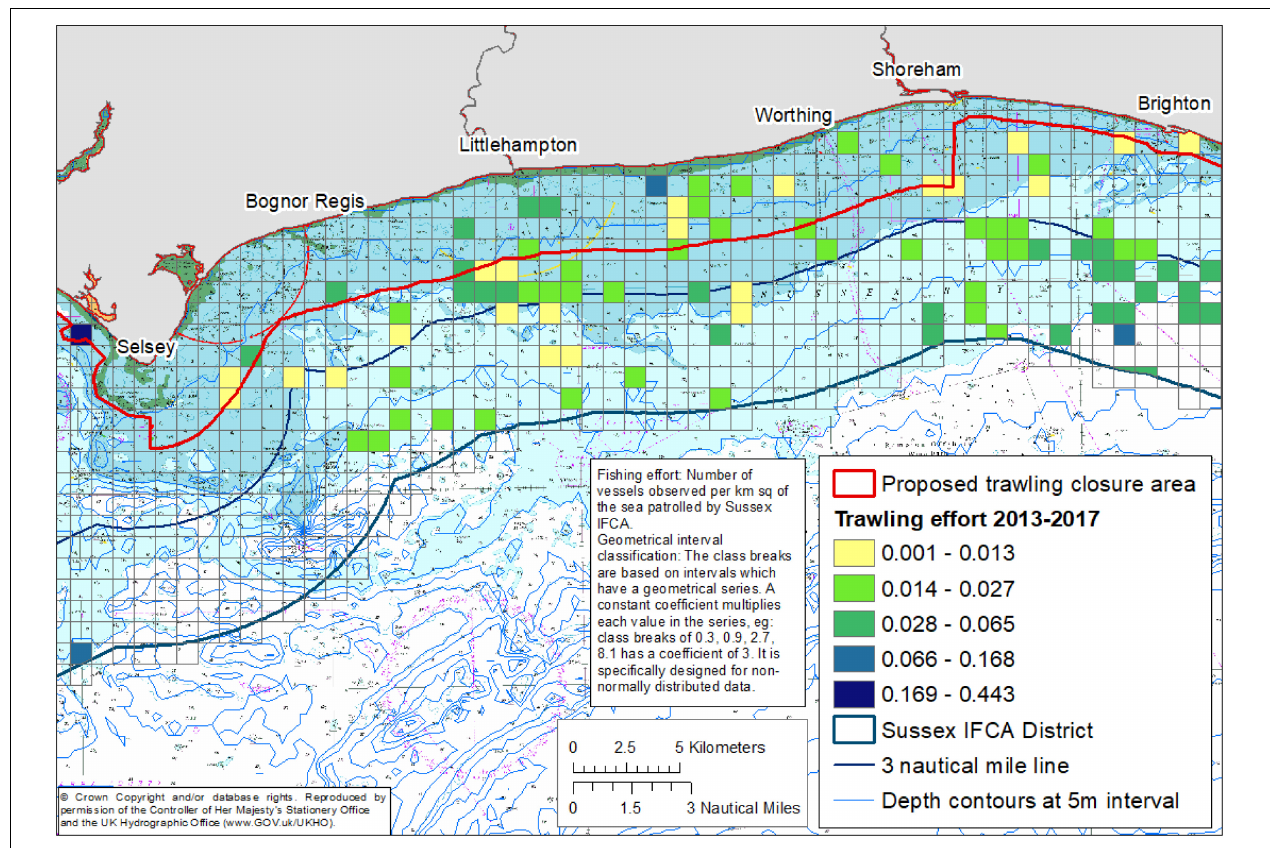
FIGURE 3 | Sightings data for towed gear and kelp observations within the Sussex IFCA district, data from 2014 to 2018. Source: Sussex IFCA.